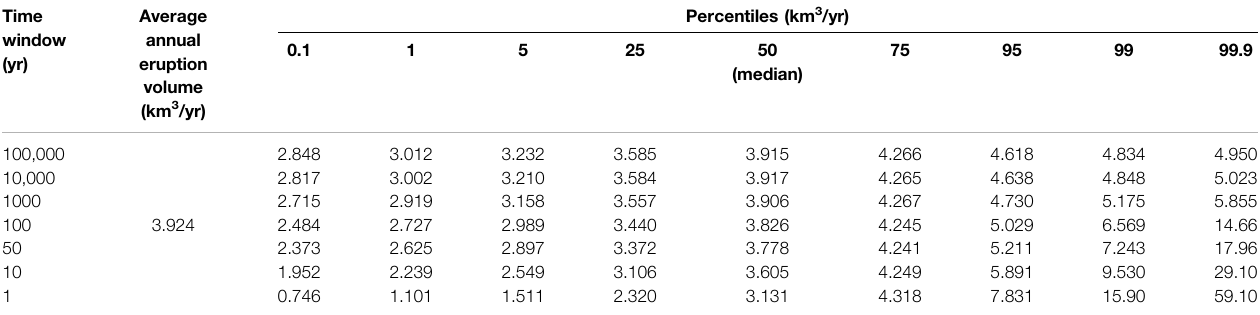
TABLE 2 | Computed average annual eruption volume from subaerial volcanism over different time